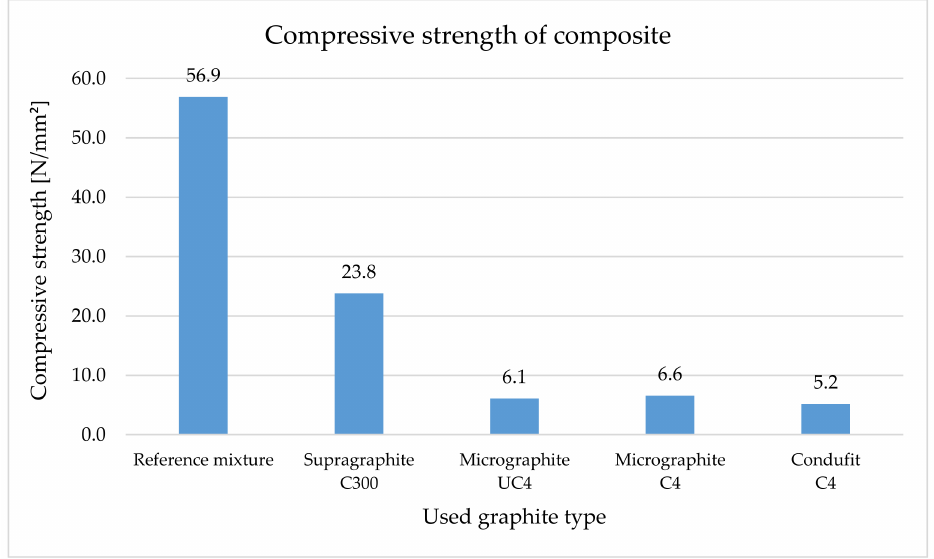
Figure 15. Compressive strength of the